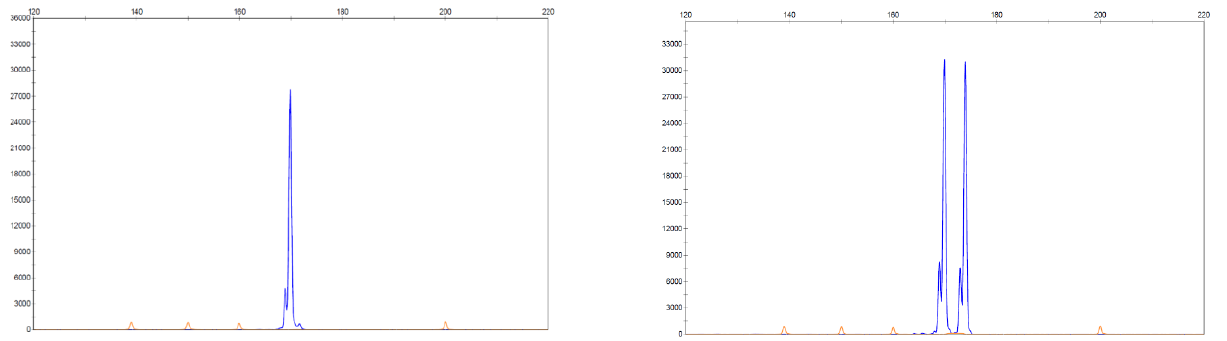
Figure 4. NPM1 detection using fragment analysis by capillary electrophoresis. The image on the left shows wild type NPM1 with the x-axis representing number of base pairs (bp) and the y-axis fluorescence. The image on the right shows the presence of a peak at 169 bp representing the wild type peak and the peak to the right at 173 bp showing the mutated NPM1 with a common 4 bp insertion. The area underneath each curve can be used to quantify the amount of wild type and mutant NPM1 present [87].